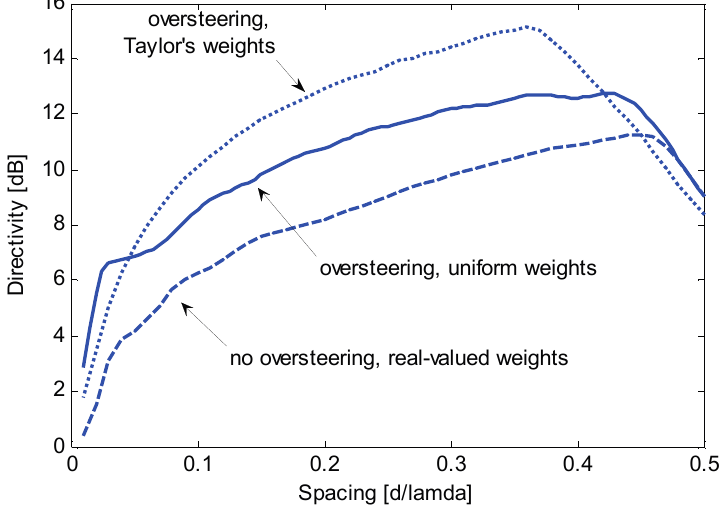
Figure 5. Maximum constrained directivity obtained for an end-fire array of N = 8 sensors by imposing WNG ≥ 0 dB using the oversteering technique with uniform weights (solid line) and Taylor’s weights (dotted line); the performance obtained without oversteering using optimum real weights is included for comparison (dashed